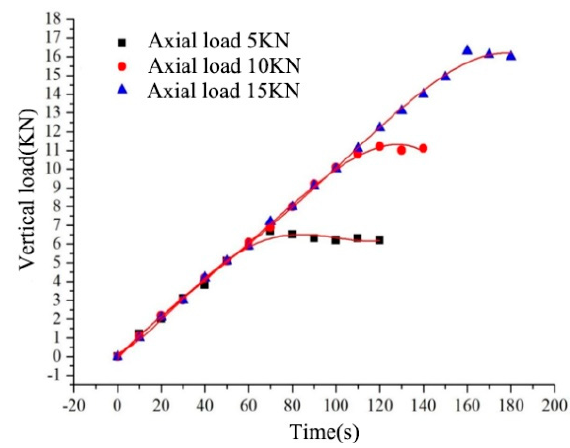
Figure 13. Equivalent friction coefficient test device.